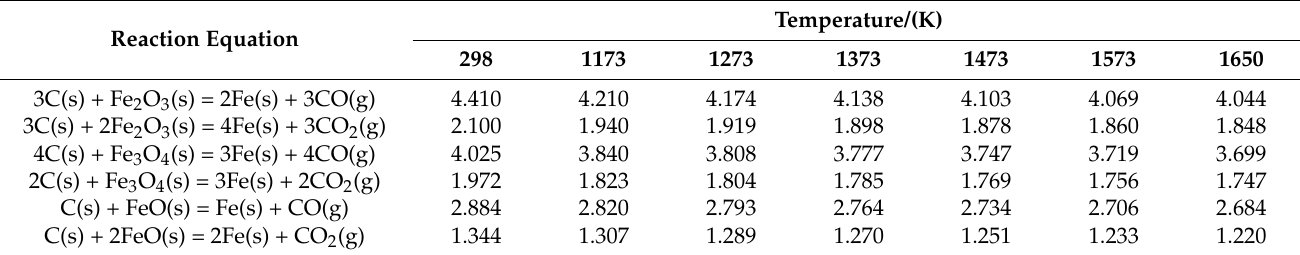
Figure 5. The standard reaction enthalpy of reduction reactions with single gas product generation as a function of temperature. Table 4. The reaction energy consumption per ton metallic iron of reduction reactions with single gas product generation at 298–1650 K